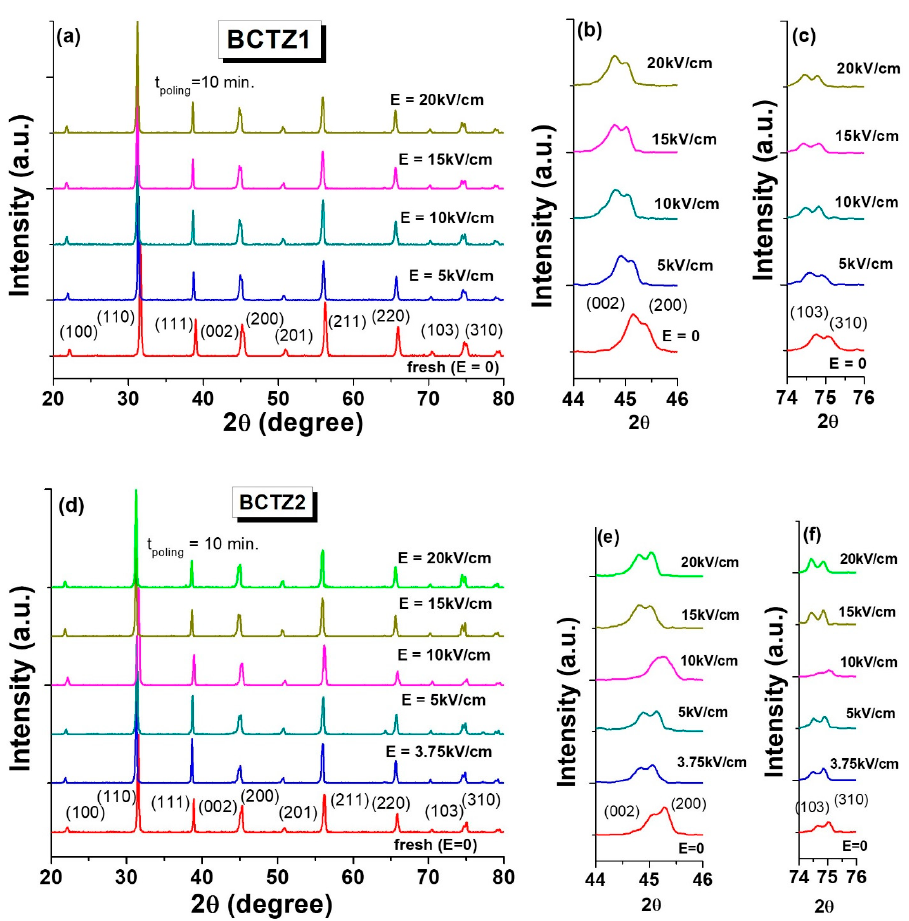
Figure 7. Experimental field-induced remanent structural modifications in BCTZ ceramics: ( a – c ) BCTZ1; ( d – f ) BCTZ2.